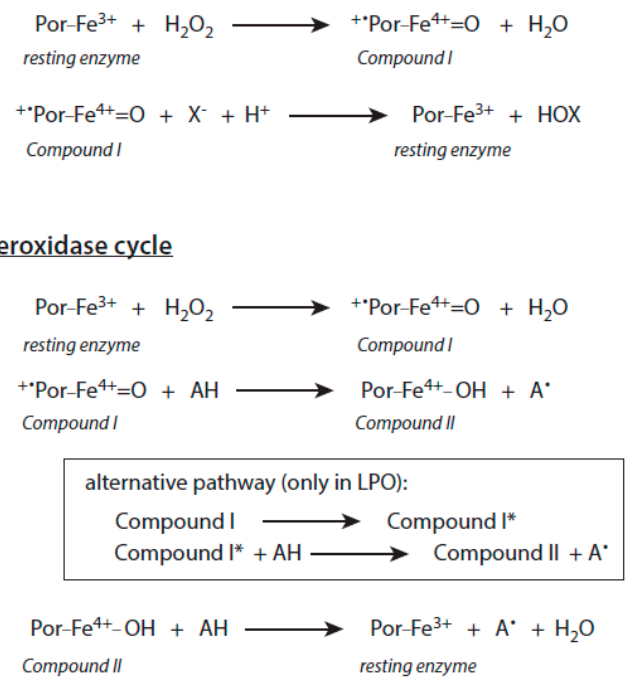
Figure 2. Halogenation and peroxidase cycles of heme peroxidases. Further explanations are given in the text. Por-Fe denotes the porphyrin-iron complex. X − stands for Cl − , Br − , I − , and SCN − . HOX is the corresponding (pseudo)hypohalous acid. AH is an oxidizable substrate, and A · the resulting substrate